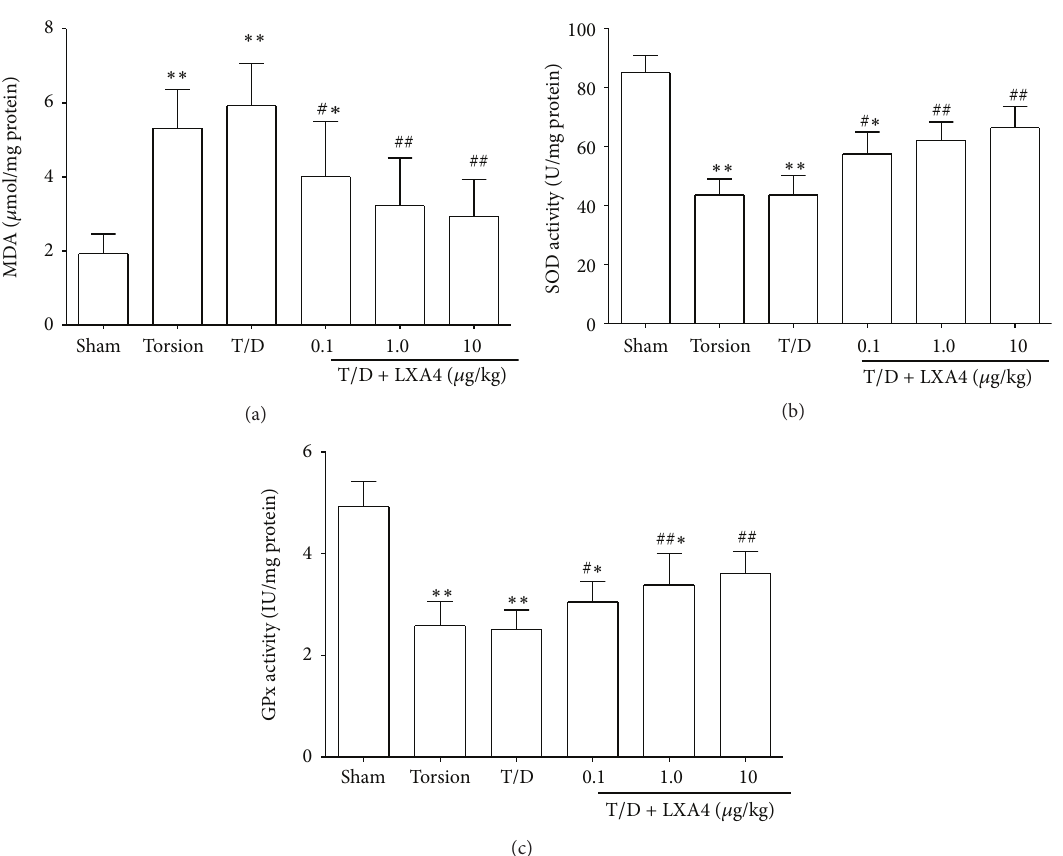
Figure 2: Changes of MDA, SOD, and GPx in testicular tissue. The levels of MDA were increased in testes after testicular torsion, while the levels of SOD and GPx were decreased. The treatment with LXA4 reverted those parameters to basal levels. Compared with Sham groups, ∗ 𝑃 < 0.05 and ∗∗ 𝑃 < 0.01 . Compared with torsion or torsion/detorsion (T/D) group, # 𝑃 < 0.05 and ## 𝑃 < 0.01 .